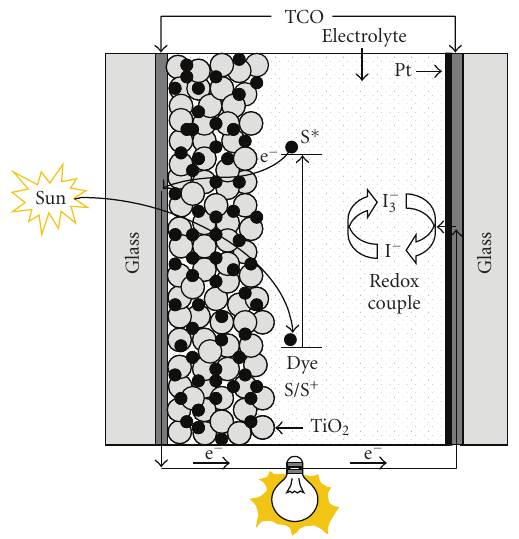
Figure 1: Schematic representation of a dye-sensitized solar